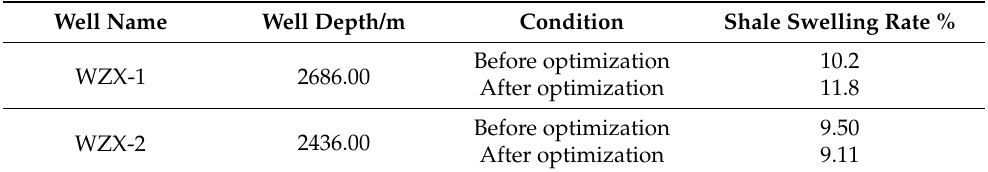
Table 3. Comparison of shale swelling rate between before/after optimization of solid-free organic salt drilling fluid.